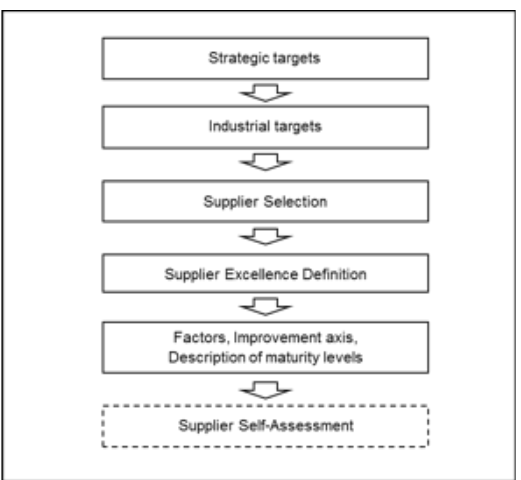
Figure 1. Company maturity model construction